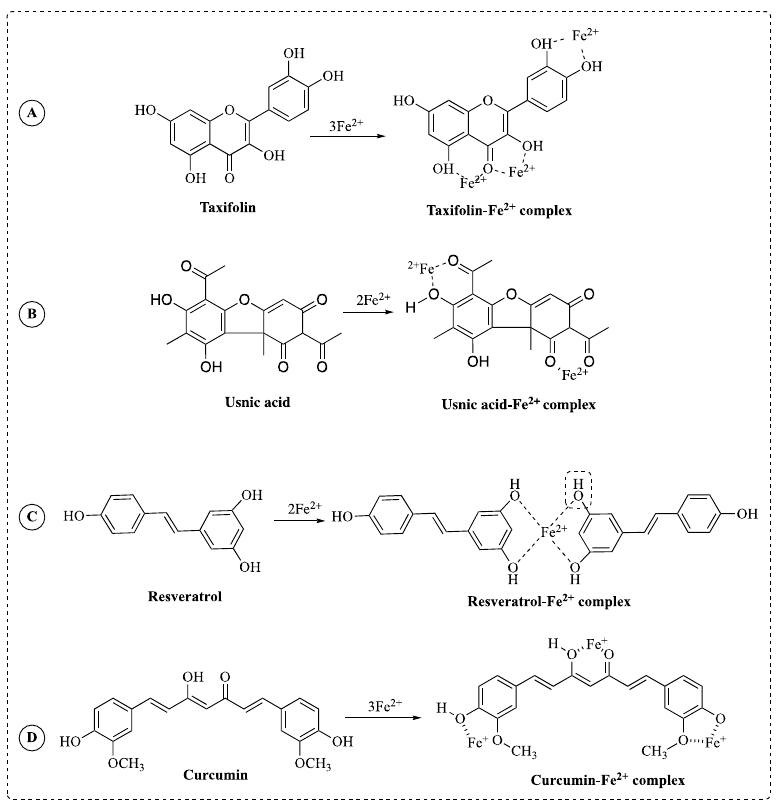
Figure 2. The suggested ferrous ions (Fe 2+ ) binding mechanism of taxifolin ( A ), usnic acid ( B ), resveratrol ( C ) and curcumin ( D ).